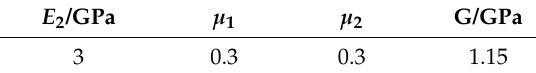
Table 1. Parameters of the model.